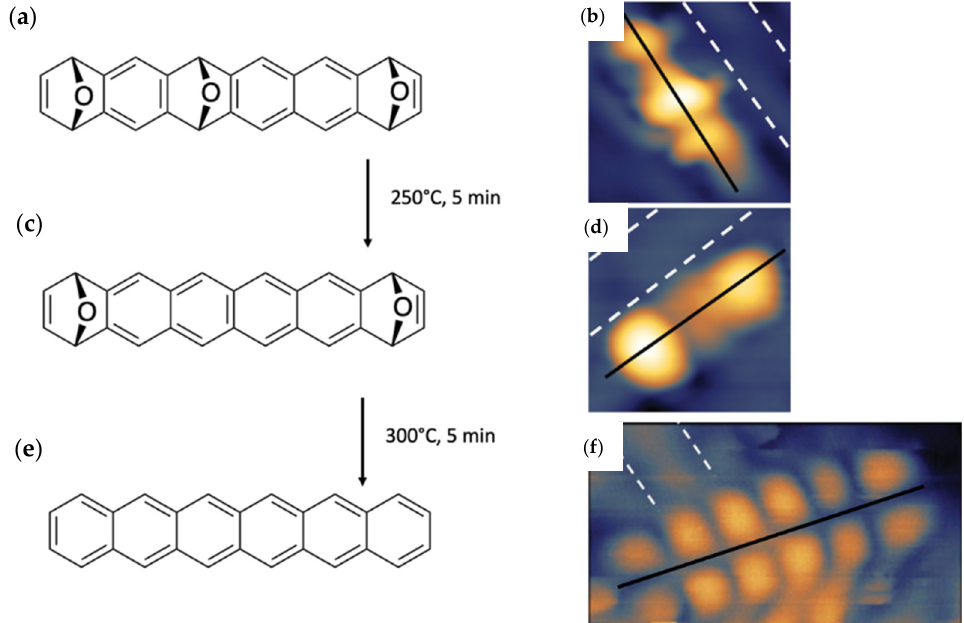
Figure 4. ( a ) Triepoxyhexacene (Hn3O) molecules, ( b ) STM image (V s = − 2.0 V, I t = 50 pA, 5 K, 2.5 × 2.5 nm 2 ) of Hn3O. ( c ) diethoxyhexacene (Hn2O) molecules obtained after thermal annealing of Hn3O and ( d ) corresponding STM image (V s = − 3.0 V, I t = 15 pA, 5 K, 2.5 × 2.5 nm 2 ). ( e ) Hexacene molecules obtained after thermal annealing of Hn2O, and ( f ) STM images (V s = − 3.5 V, I t = 15 pA, 5 K, 8 × 2 nm 2 ). All STM images are obtained on a Si(001)-(2x1): H surface. The white dashed lines indicate the dimer row direction, and the black line shows the direction of the investigated